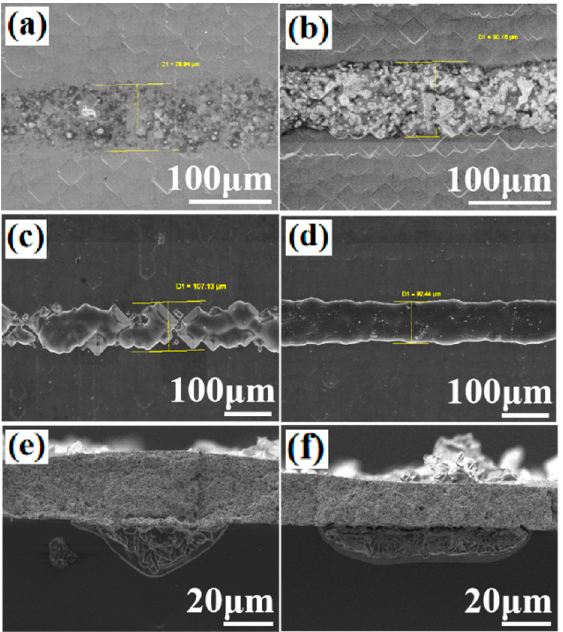
Figure 10. ( a ), ( b ) SEM surface images obtained using the 10% and 30% solid glass frit in the glass pastes; ( c ), ( d ) SEM images of the etching area after the Al paste had been removed; ( e ), ( f ) cross-sectional SEM images of the contact area.